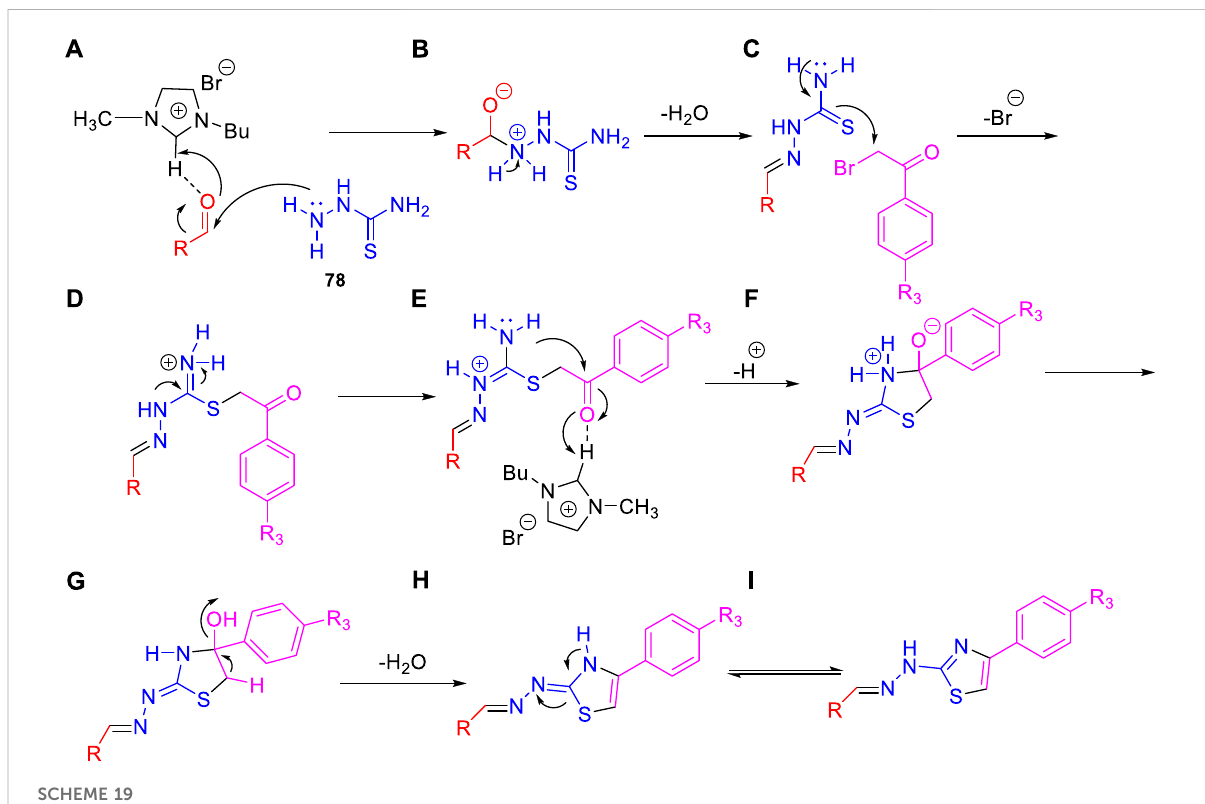
SCHEME 19 Plausible mechanism for the formation of 1-((6-phenylimidazo [2,1-b][1,3,4]thiadiazol-5-yl)methylene)-2-(4-phenylthiazol-2-yl)hydrazine derivatives.